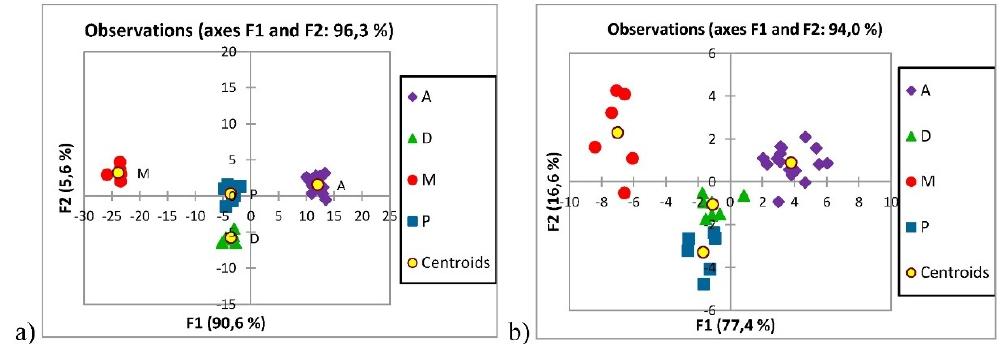
Figure 5. Discriminant score plots ( a ) of the 36 Slovenian potato samples from the Alpine (A; n = 16), Dinaric (D; n = 8), Mediterranean (M; n = 6), and Pannonian (P; n = 6) regions ( b ) with the rare earth elements excluded. The centroids represent the means of each group (Source: [38]).